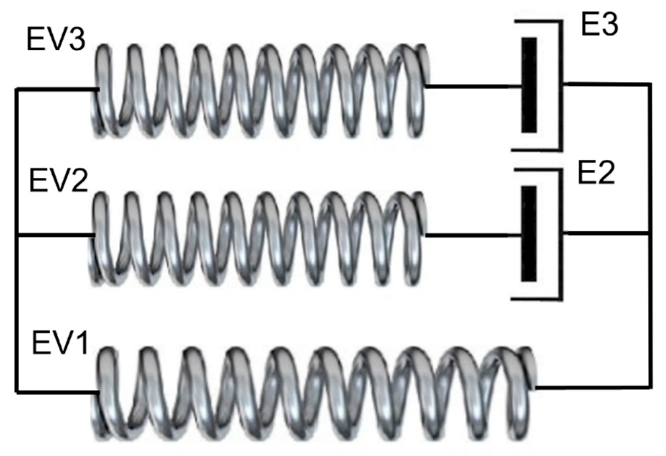
Figure 7. Three-arm model model with Arm 1 as an Edwards-Vilgis model and Arms 2 and 3 each as an Edwards-Vilgis in series with an Eyring process.